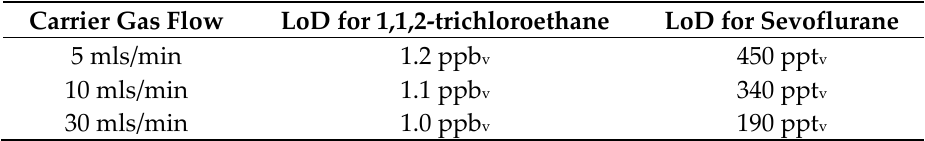
Table 1. Limits of Detection (LoD) for 1,1,2-trichloroethane and sevoflurane for carrier gas flows between 5 mls/min and 30 mls/min for a measuring time of 200 ms and U col = 5